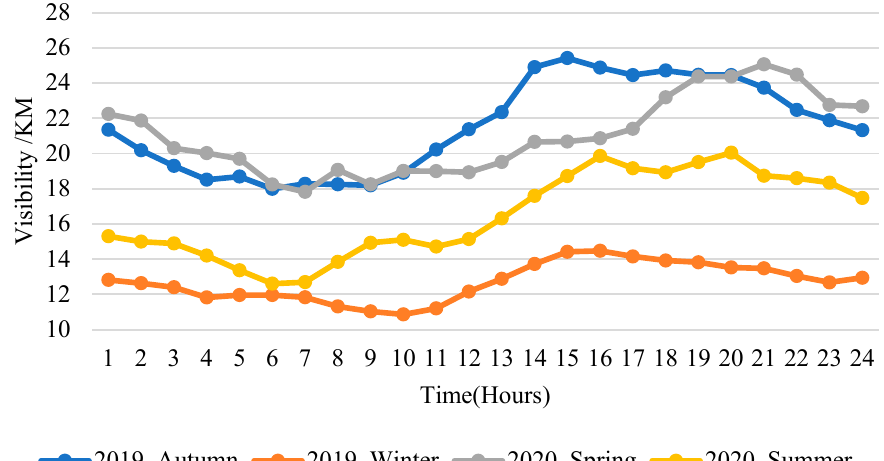
Figure 3. Diurnal variation of visibility in different seasons in Qingdao .